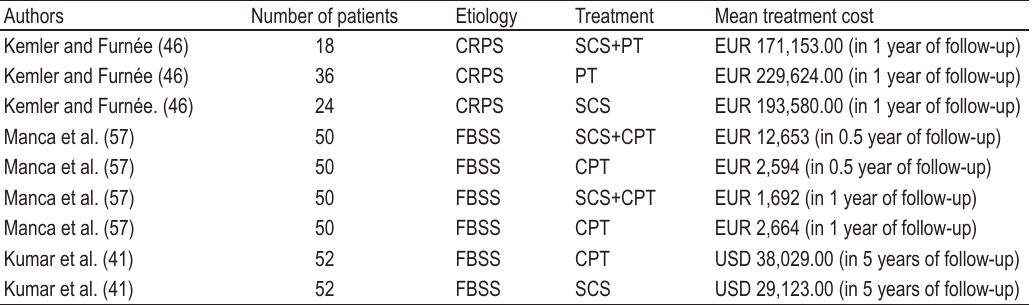
TABLE 4. Cost-effectiveness of main neuropathic pain therapies